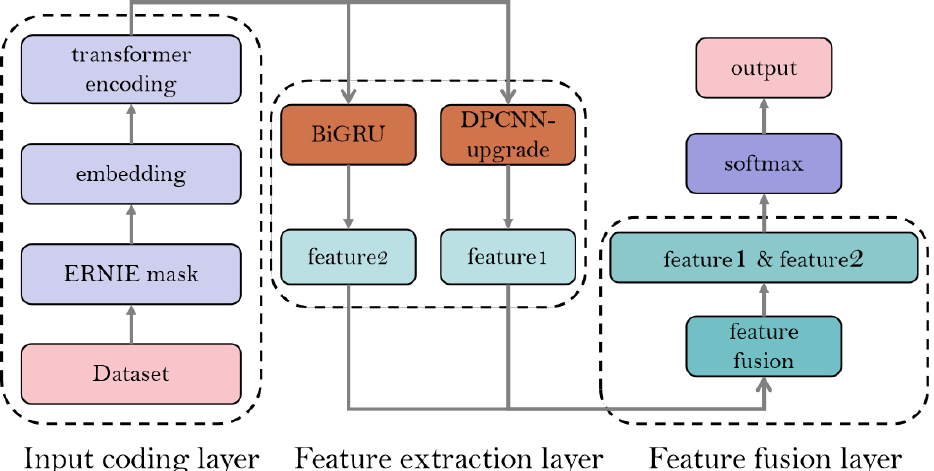
Figure 4. EGC model structure. Figure 4. EGC model